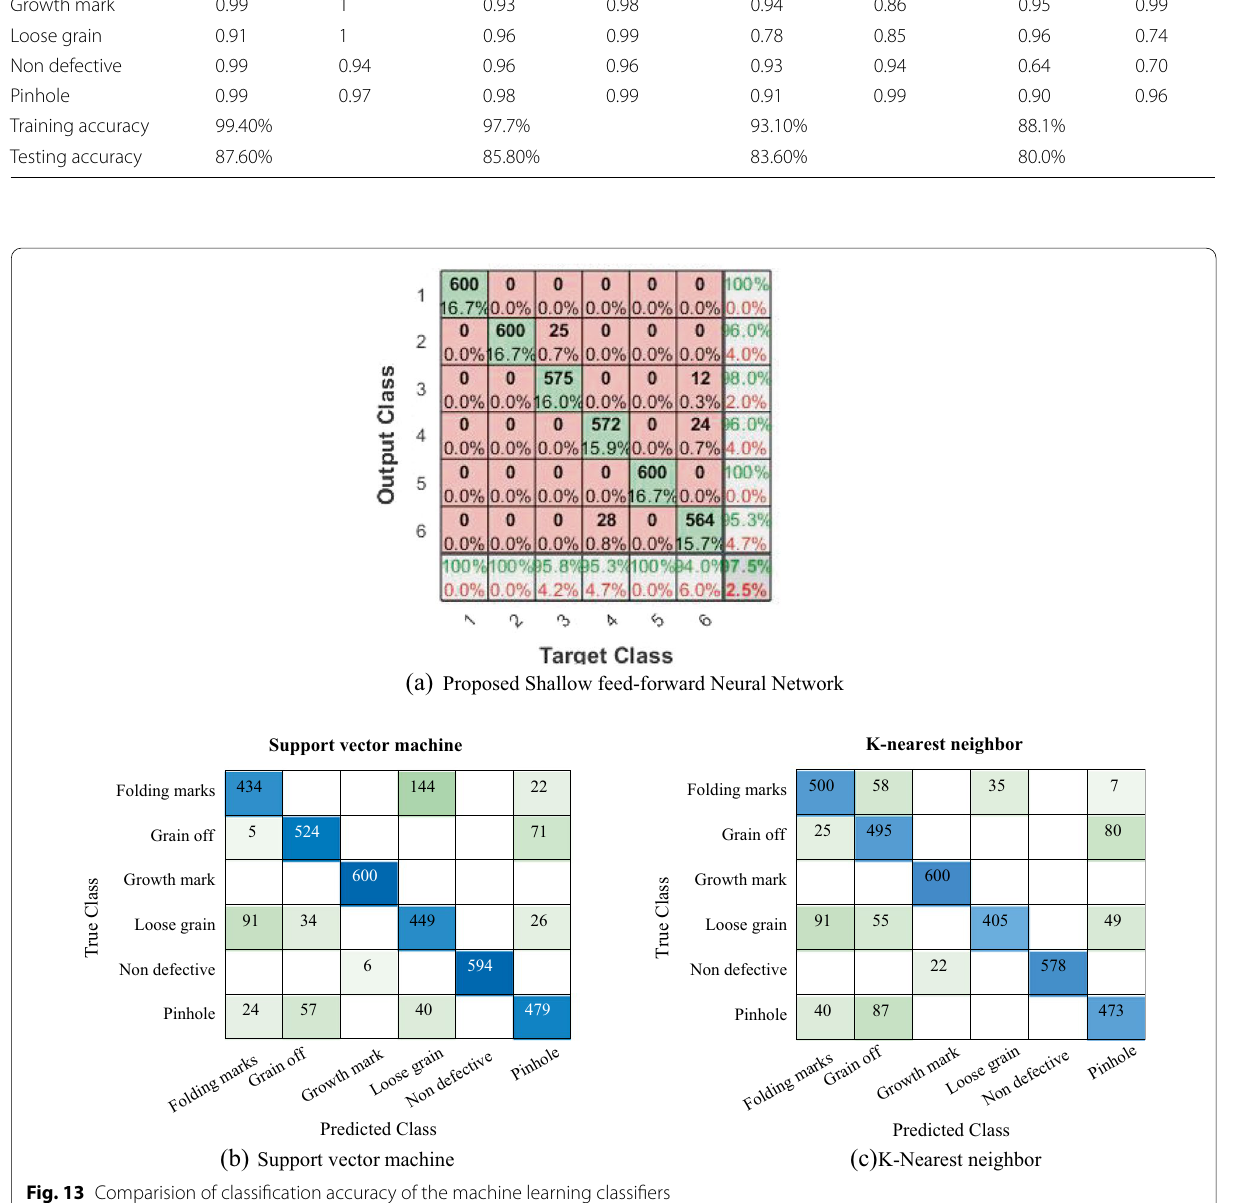
to incorrect responses. The percentage values in the far- right column of the confusion matrix shows the preci- sion (or positive predictive value) and false discovery rate of the proposed neural network for the classification of